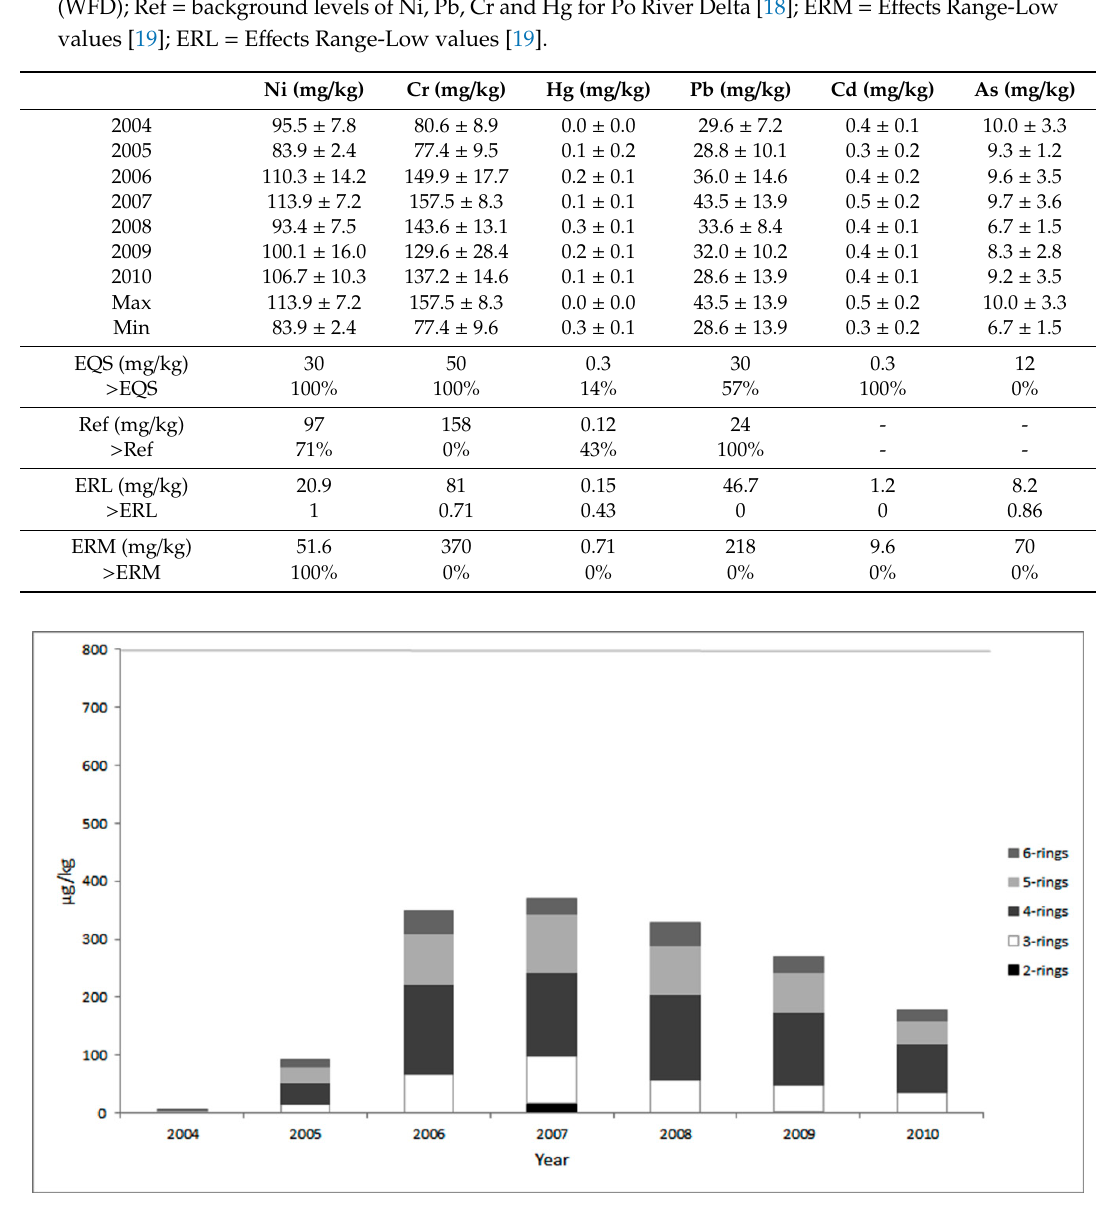
Figure 3. Annual average of polycyclic aromatic hydrocarbons (PAHs) ( Σ 16PAHs in µ g / kg) for 2004 to 2010 (n = 4) and group profiles of LPAHs (two or three-fused rings) and of HPAHs (four to six-fused rings) in the sediments from Sacca di Goro. The EQS limit (Good/Moderate) for the sum of PAHs according to the WFD is indicated.